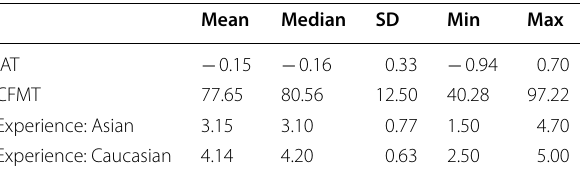
Table 1 The descriptive statistics for the measures of implicit racial bias (IAT), face recognition ability (CFMT), and experience with Asian and Caucasian people (N =